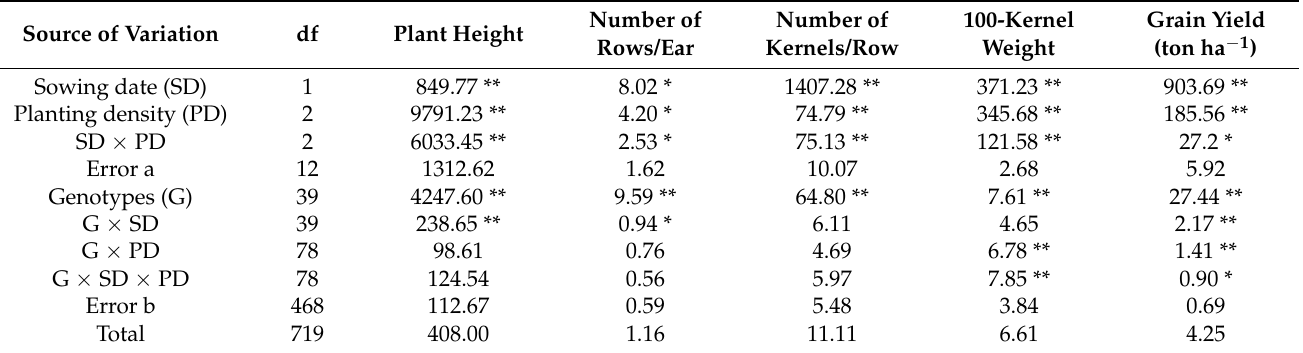
Table 1. Combined analyses of variance (mean square) of 40 hybrids under three planting densities in two sowing dates for grain yield and its